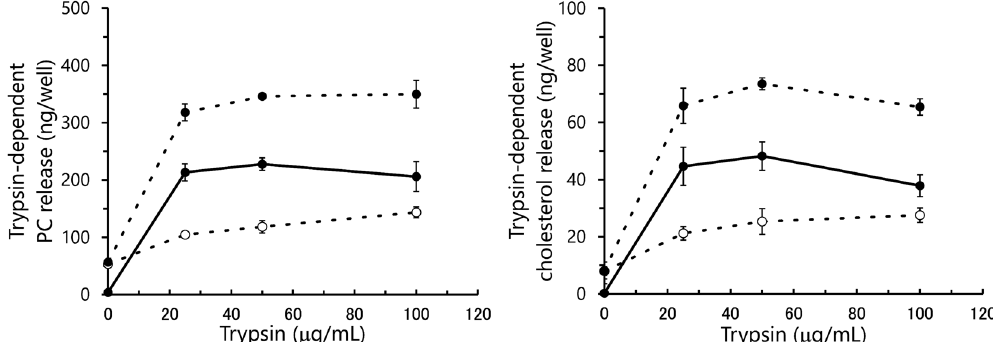
Figure 1. Trypsin-dependent PC and cholesterol release from BHK/ABCA1 cells. BHK/Mock ( ○ , dotted line) and BHK/ABCA1 ( ● , dotted line) cells were incubated with 0, 25, 50, or 100 μ g/mL of trypsin for 60 min at 37 °C. The amounts of PC and cholesterol released into the medium were measured. ABCA1-specific release of PC and cholesterol ( ● , solid line) were calculated by subtracting the release from BHK/Mock cells from the release from BHK/ABCA1 cells. Experiments were performed in triplicate, and the average values are shown with